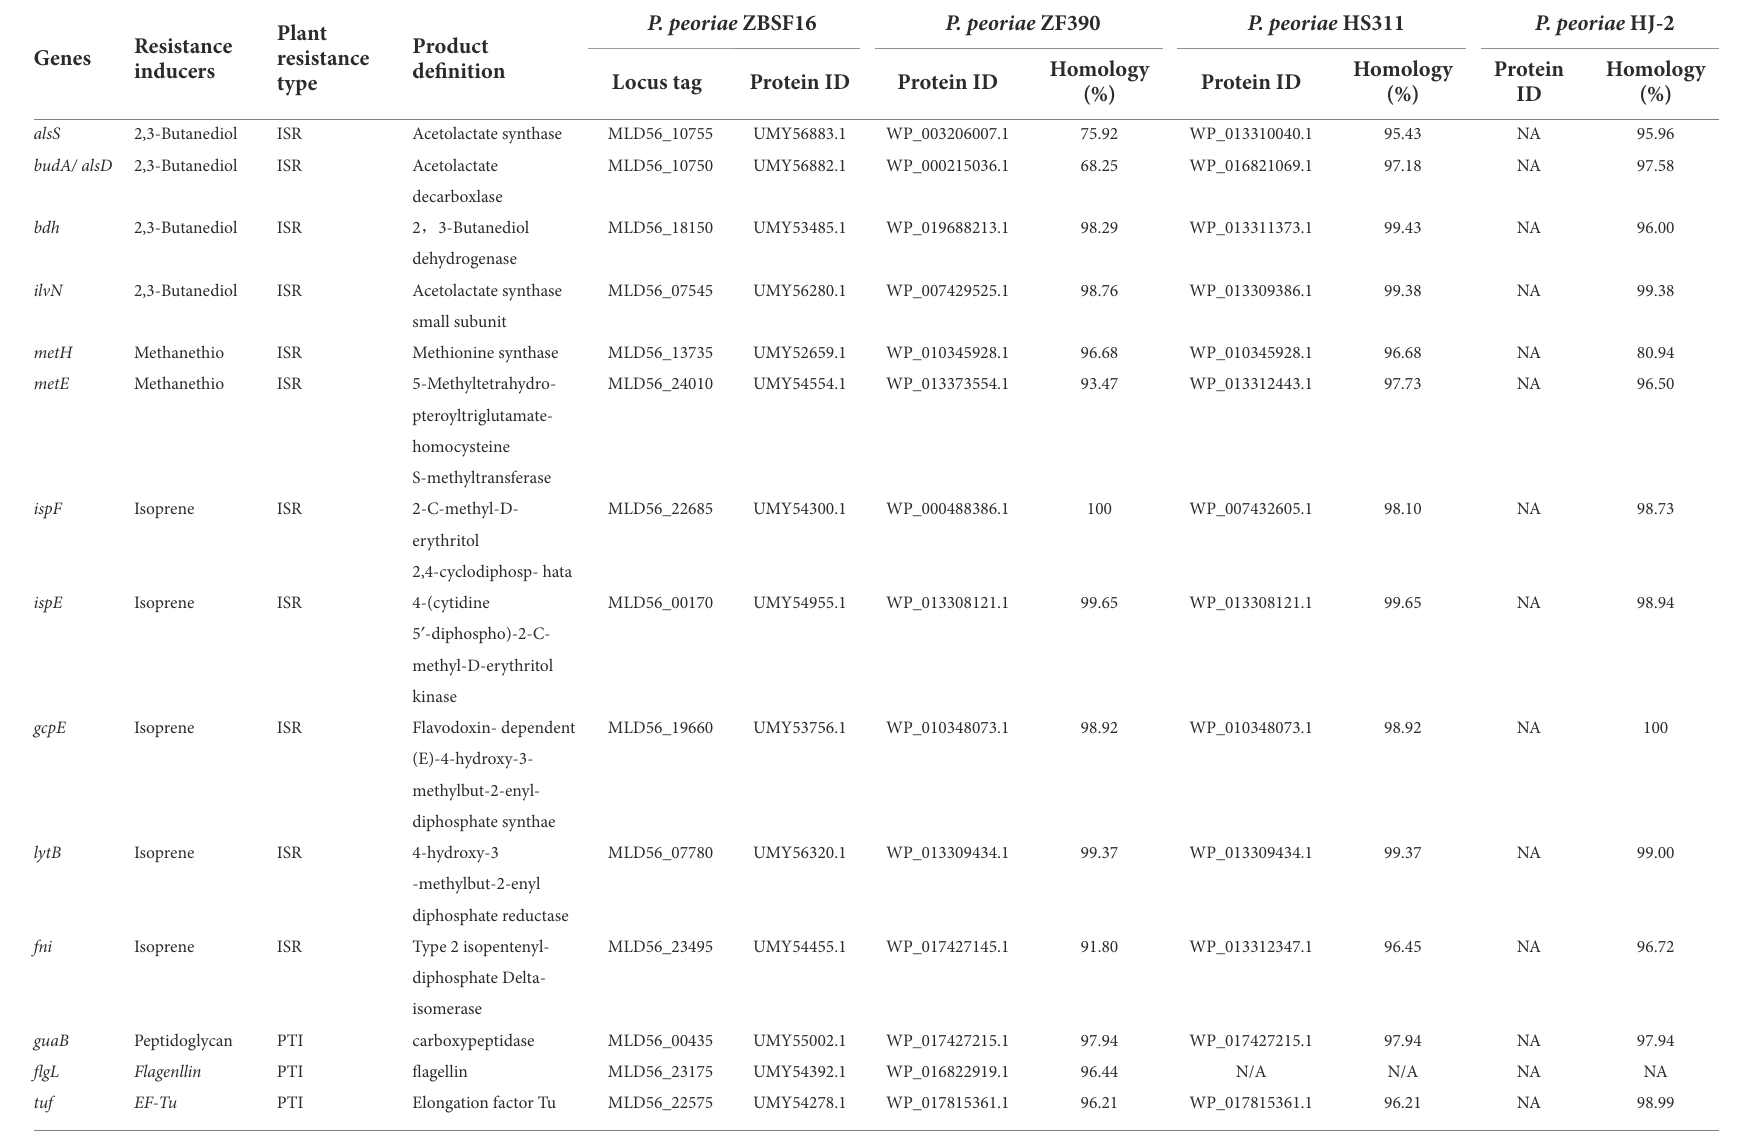
TABLE 3 Genes related to synthesis resistance inducer in Paenibacillus peoriae ZBSF16 and other P. peoriae